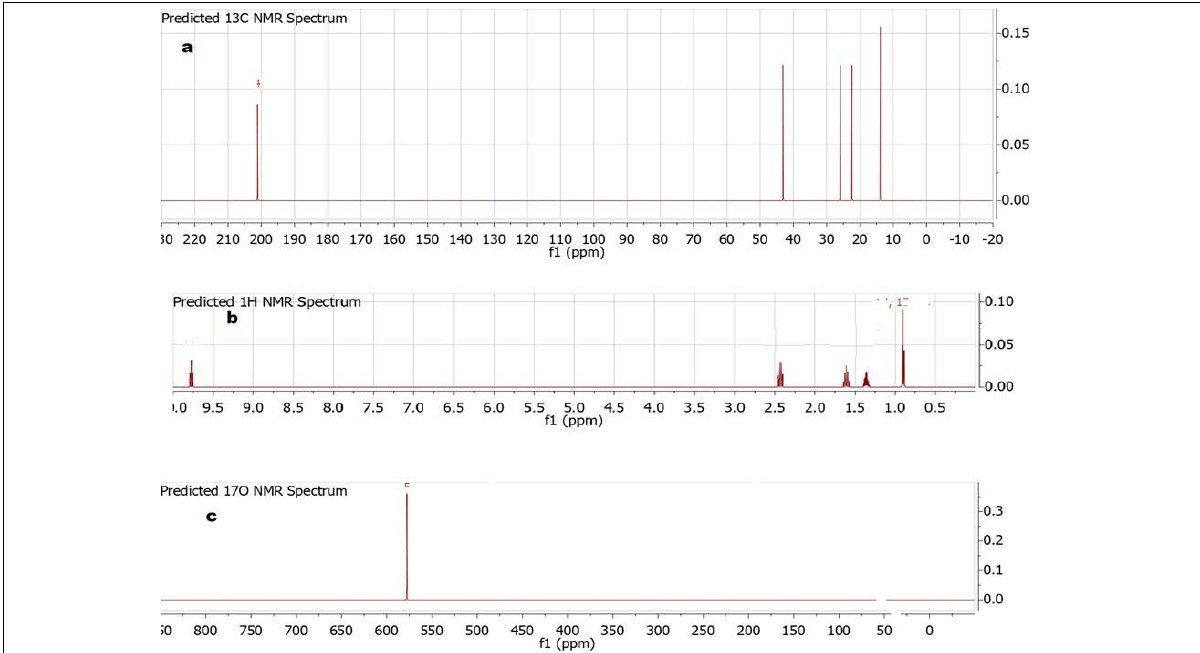
Figure 5: Nuclear magnetic resonance (NMR) spectra of valeraldehyde: (a) carbon, (b) hydrogen and (c)